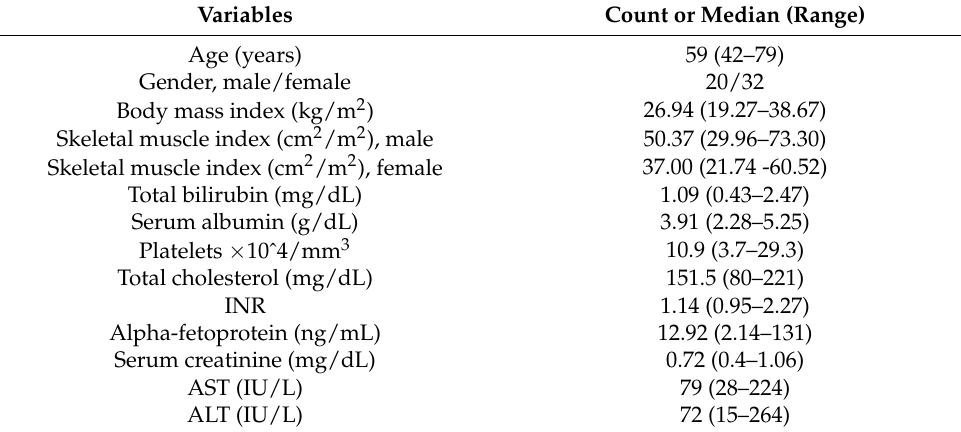
Table 1. Baseline characteristics of the